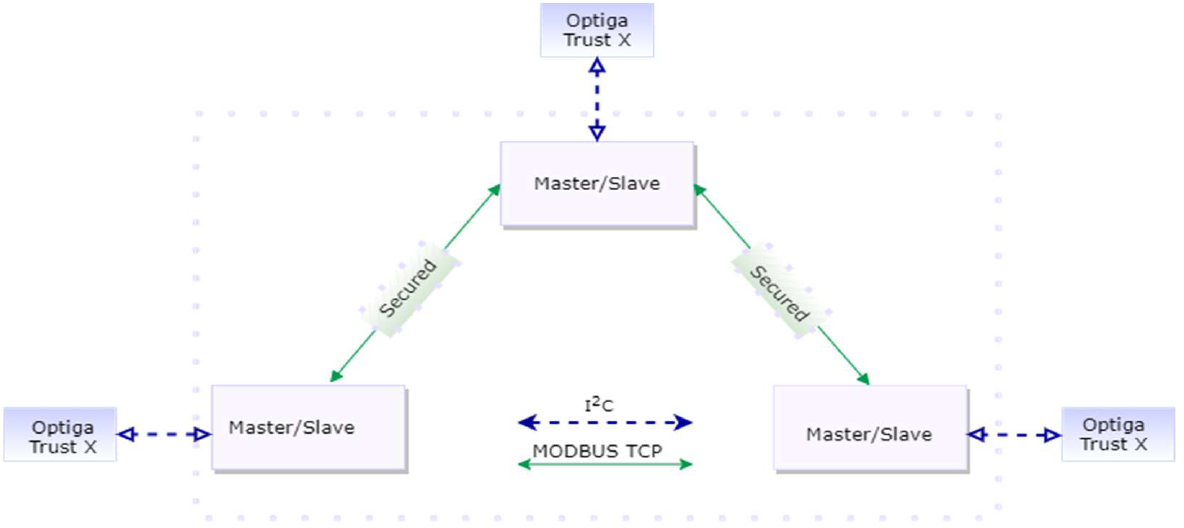
Figure 1. System Architecture.